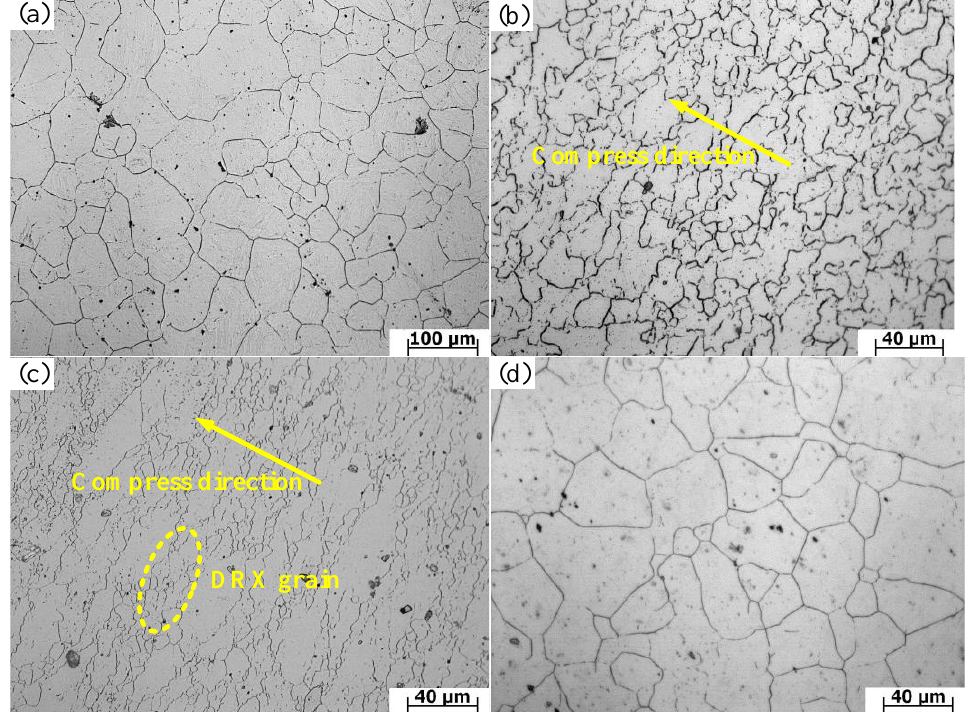
Figure 3. Microstructure of X12 ferritic heat-resistant steel under various deformation conditions: ( a ) original microstructure; ( b ) 1100 °C/0.05 s −1 ; ( c ) 1100 °C/0.5 s −1 ; ( d ) 1250 °C/0.5 s −1 . ( a ) original microstructure; ( b ) 1100 ◦ C/0.05 s − 1 ; ( c ) 1100 ◦ C/0.5 s − 1 ; ( d ) 1250 ◦ C/0.5 s − 1